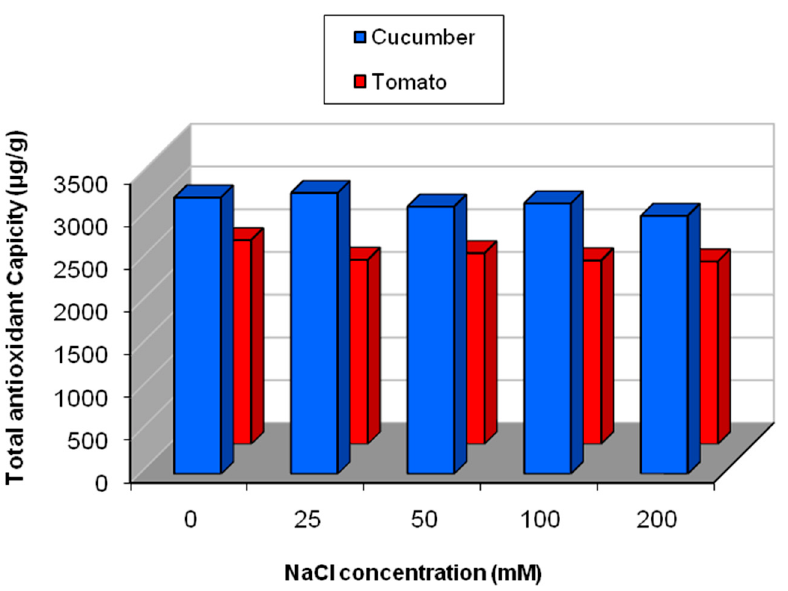
Figure 8. Total antioxidant capacity in cucumber and tomato under NaCl stress.